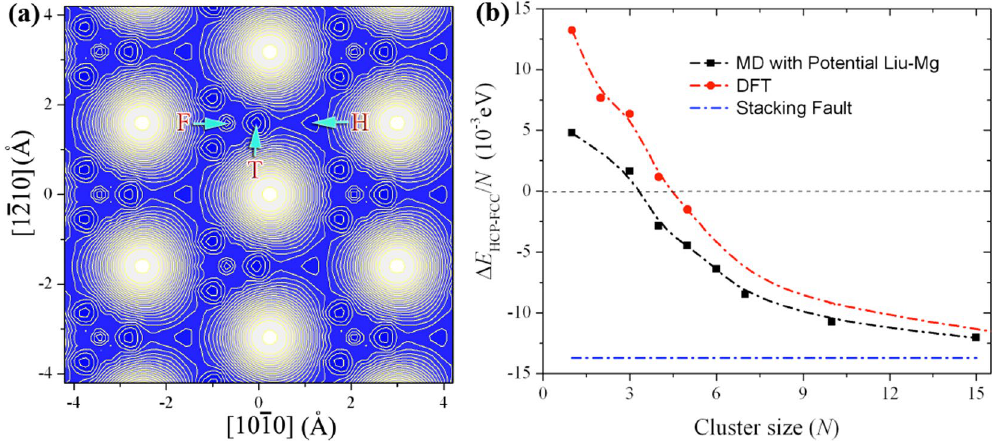
Figure 2. ( a ) The surface potential landscape in association with diffusion of an adatom on surface (0001), revealing three local stabilized sites, the fcc site (F-site), the hcp site (H-site) and the tetrahedral site (T-site) in a fcc structure. ( b ) The variation of the energy difference between the fcc and hcp structures with the cluster size. Δ E HCP − FCC / N represents the average energy difference between the fcc and hcp structures of a cluster on the surface. The blue dashed line indicates the energy difference corresponding to the stacking fault in hcp